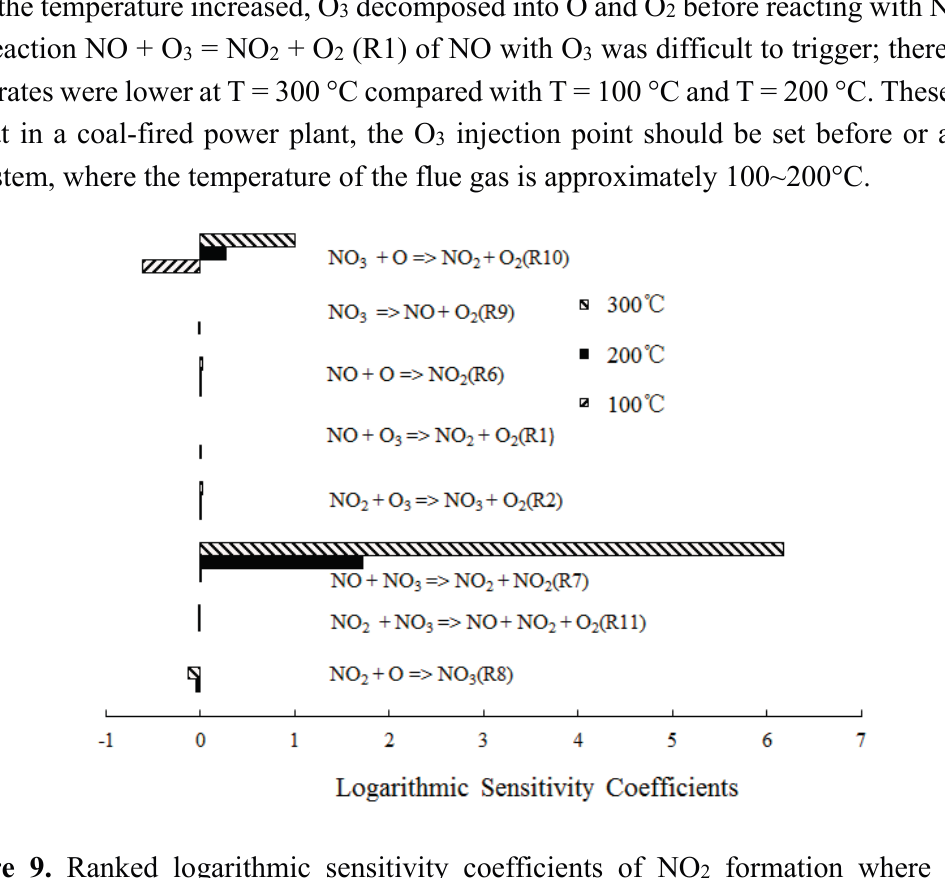
Figure 9. Ranked logarithmic sensitivity coefficients of NO 2 formation where O 3 /NO concentration equals